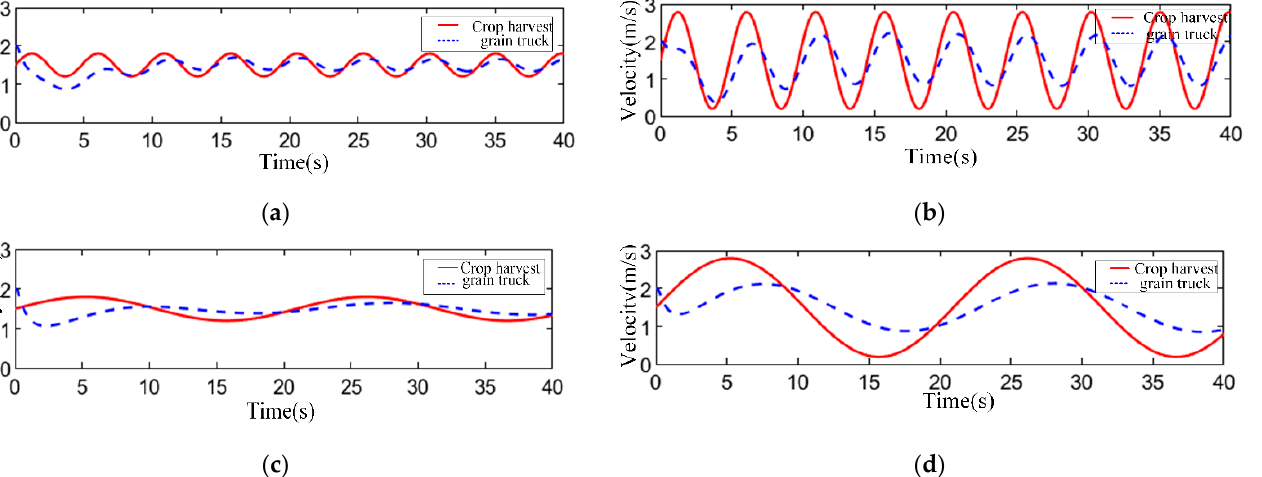
( a ) Low magnitude high frequency; ( b ) High magnitude high frequency; ( c ) Low magnitude low Figure 7. Following simulation diagram under the influence of velocity magnitude fluctuation. ( a )